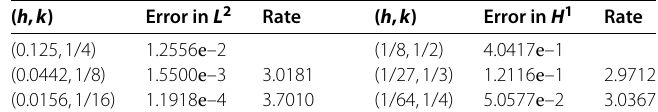
Table 6 The errors and convergence rates of v – v hk in the L 2 and H 1 norms concerning k at